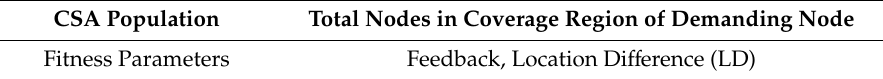
Table 1. The specifications considered for the Cuckoo search algorithm (CSA).